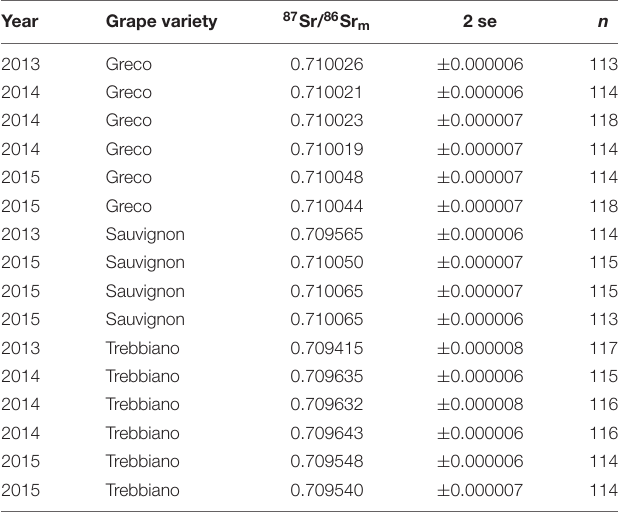
The mean values of the (n) measurements and 2 se deviations are reported. TABLE 3 | Isotopic composition of the must divided by vintage years and grape